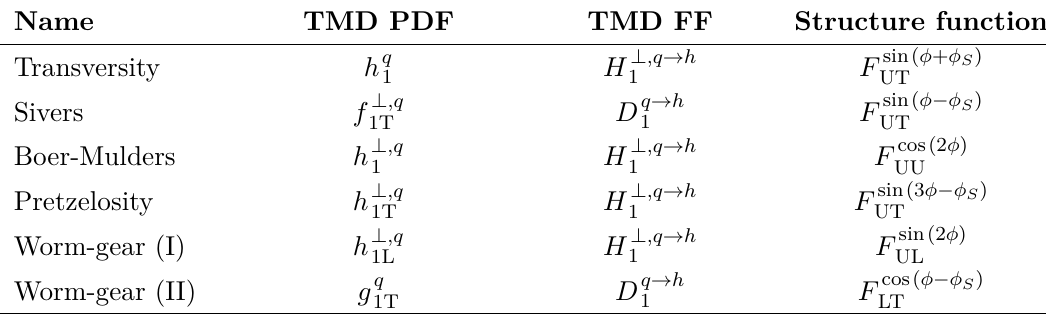
Table 2 . Leading-twist TMD PDFs that do not survive integration over p T , together with the TMD FFs with which they appear in their associated leading semi-inclusive DIS structure